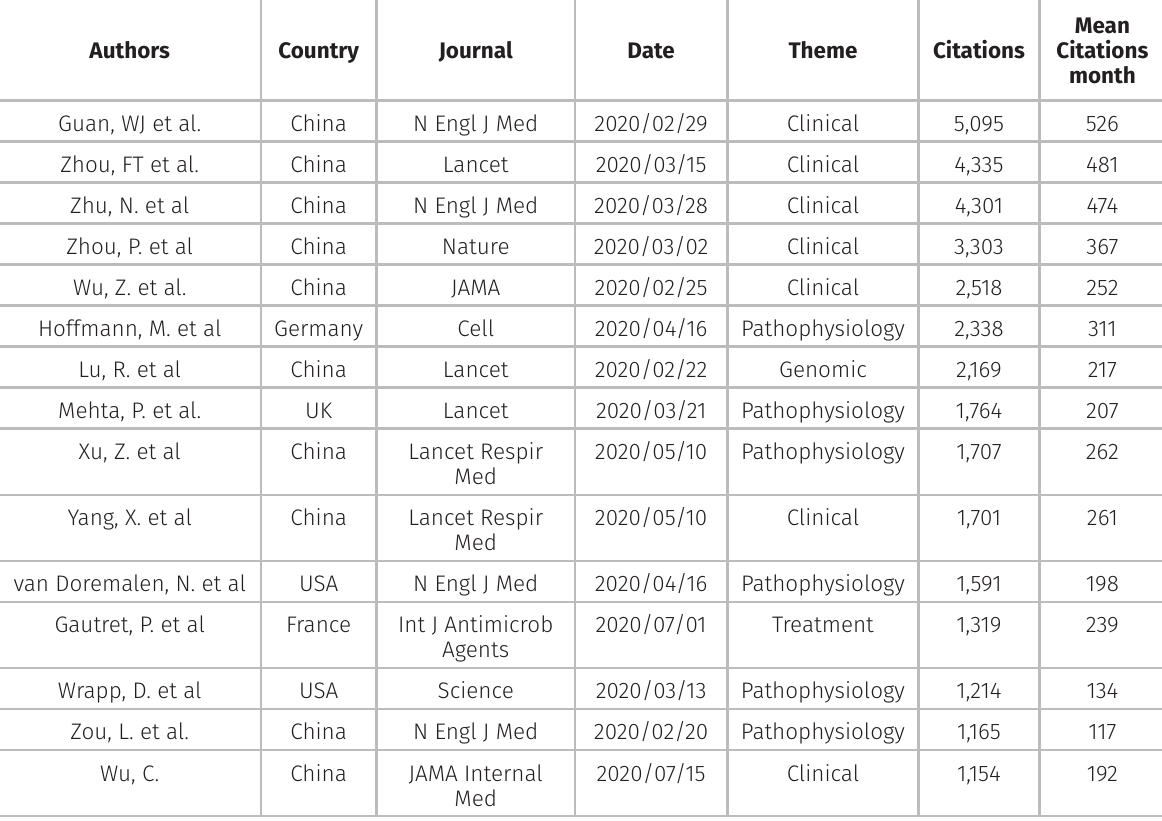
Table I. The 15 most cited COVID-19 articles until December 13,